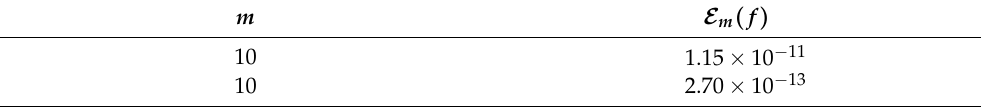
Table 2. Example 2: Errors in rational Gauss rules for approximating (24) with A a symmetric positive definite Toeplitz matrix. In the first row, the poles are α i ∈ {− 1/2, − 1, − 3/2, − 2 } of multiplicity one. The second row shows the error when the poles are allocated by using (23) with α = 0 and (cid:96) = 4. The poles are α i ∈ {− 0.0396, − 0.4465, − 2.2398, − 25.2741 } of multiplicity one. m